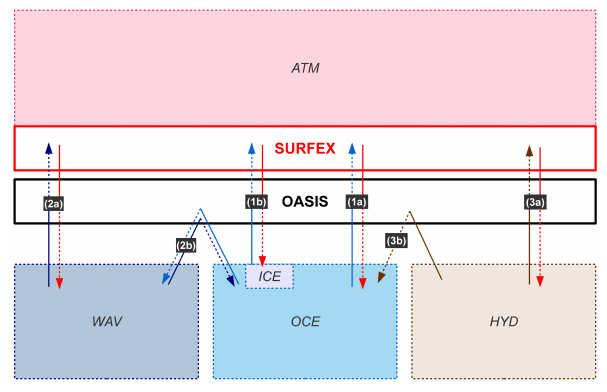
Figure 1. Flow chart of the SURFEX-OASIS coupling interface. An ocean model (OCE), possibly including a sea-ice model (ICE), a wave model (WAV) and a hydrological model (HYD), can ex- change fields with the SURFEX interface (arrows 1a, 1b, 2a and 3a). Exchanges between OCE and WAV (and HYD) are also possi- ble through OASIS (arrows 2b and 3b). When using an ATM com- ponent, SURFEX is embedded in the ATM